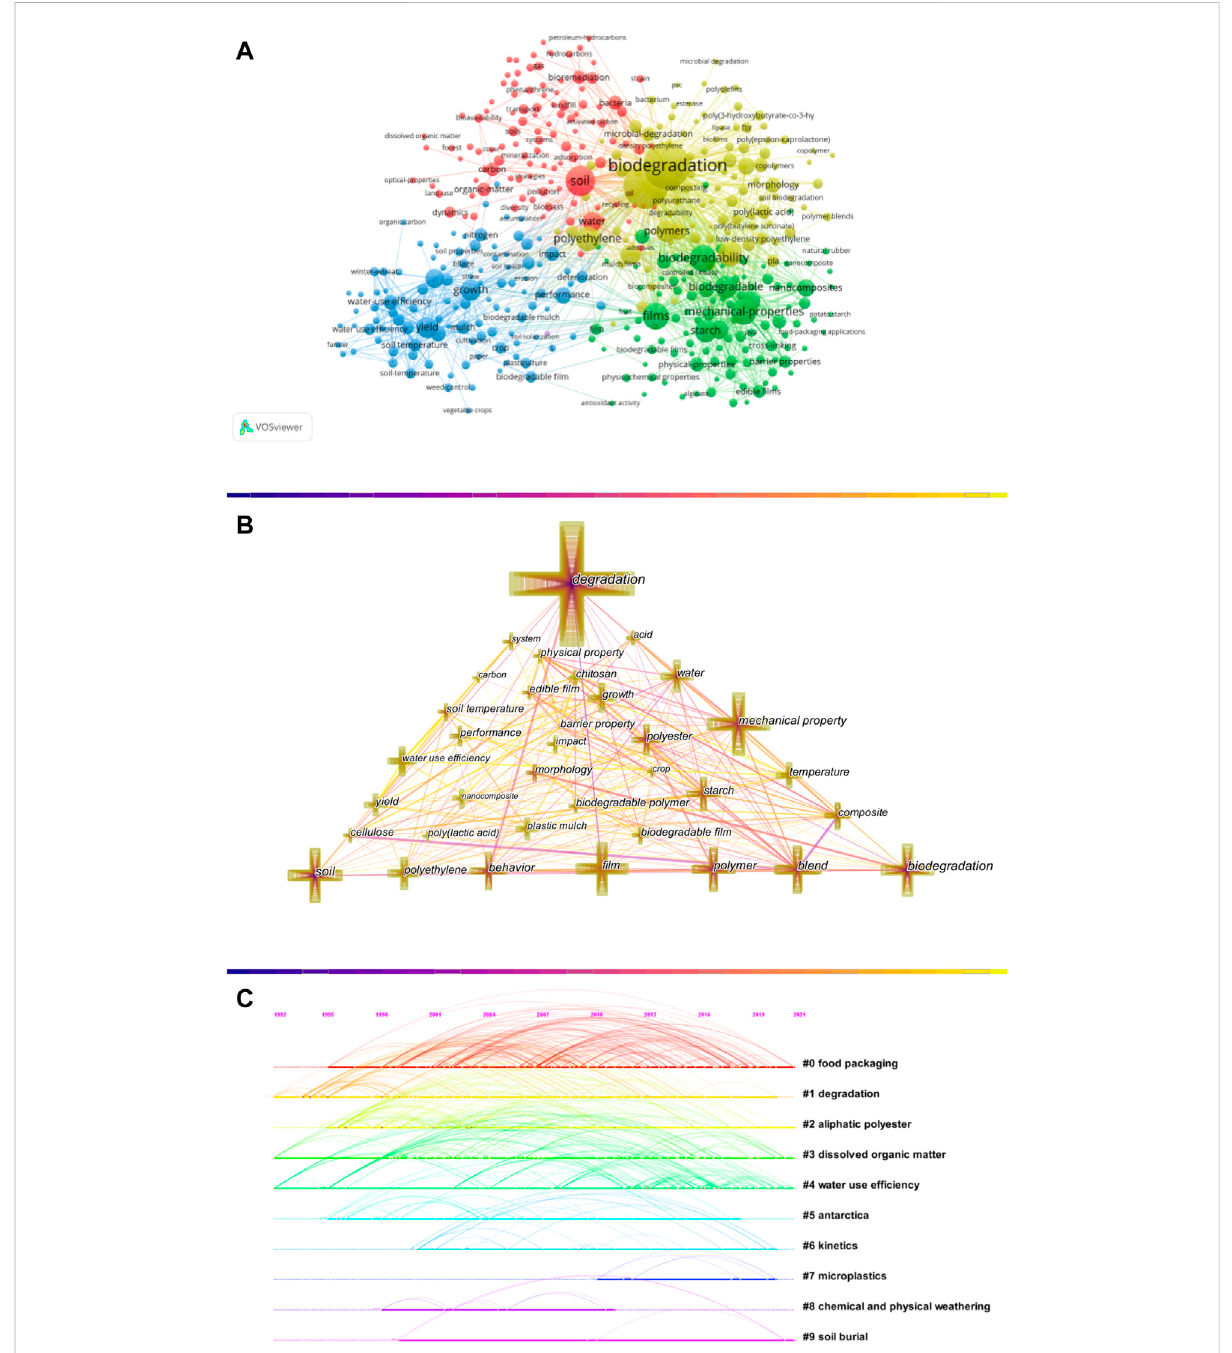
Frontiers in Bioengineering and